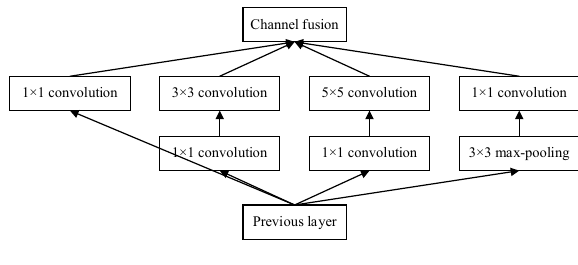
Fig. 2 Single Inception structure